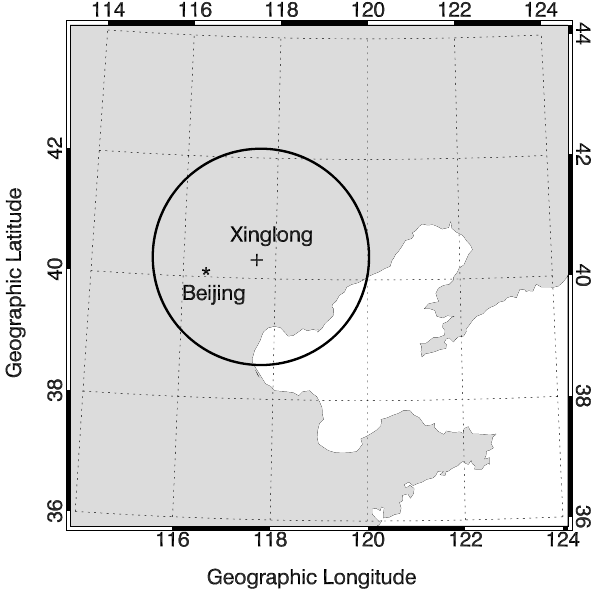
Fig. 1. Map showing the location of the all-sky airglow imager at Xinglong (40.2 ◦ N, 117.4 ◦ E). The circle has a radius of 200km, which corresponds to a zenith angle of 67 ◦ for a height of